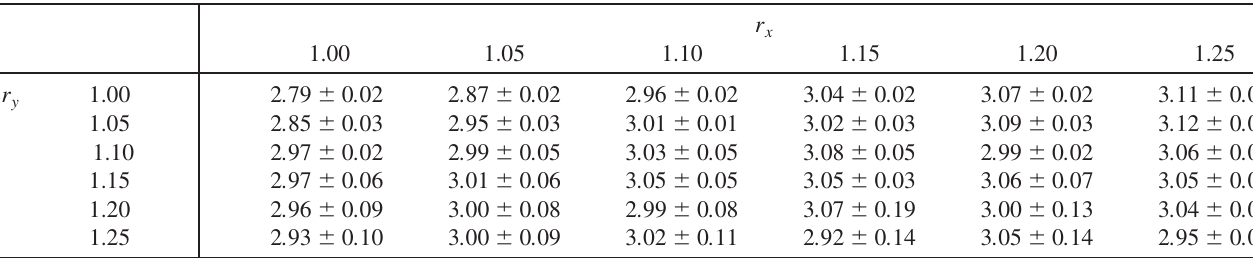
TABLE II. Normalized luminosity L in units of 10 11 as a function of the size ratios r x ¼ (cid:6) x;e =(cid:6) x;p , and r y ¼ (cid:6) y;e =(cid:6) y;p . The norm subscript ‘‘ e ’’ refers to the electron lens beam, while the subscript ‘‘ p ’’ corresponds to the proton beam. Since we deliberately chose the same beta functions at both the IP and the electron lens, equal beam sizes (cid:6) x;e ¼ (cid:6) x;p , (cid:6) y;e ¼ (cid:6) y;p and intensities N e ¼ N p correspond to the case of full beam-beam compensation.